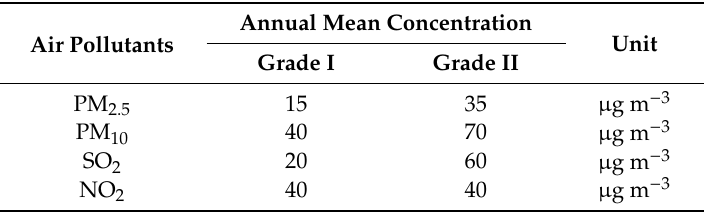
Table 3. Ambient air quality standard in